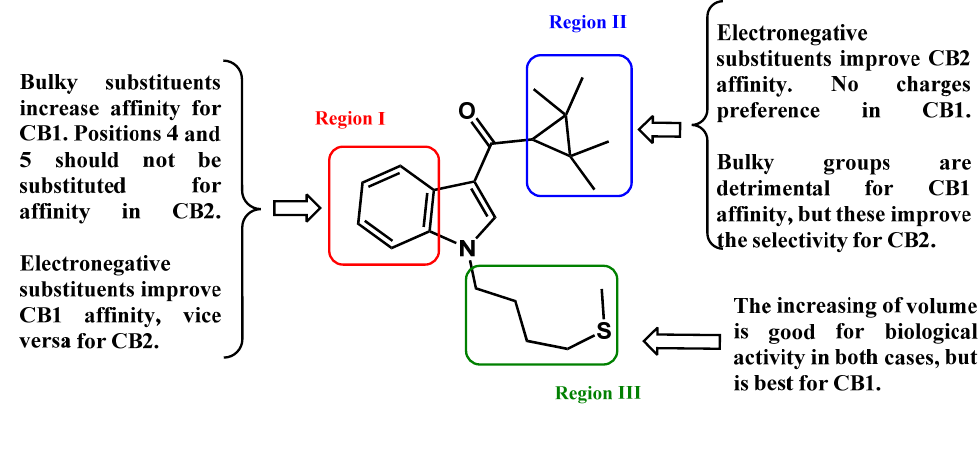
Figure 5. Structure-affinity/selectivity relationships derived from CoMFA studies developed in this